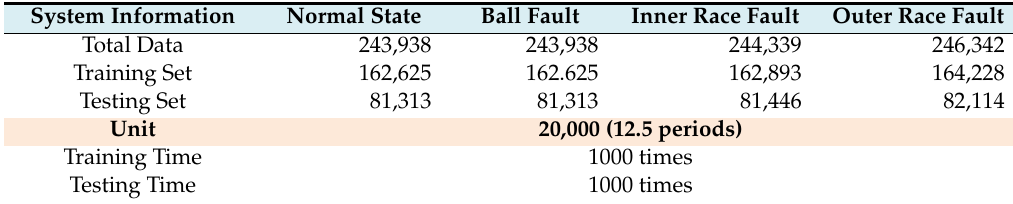
Table 3. The detailed operation procedure of the smart machine for di ff erent four states.